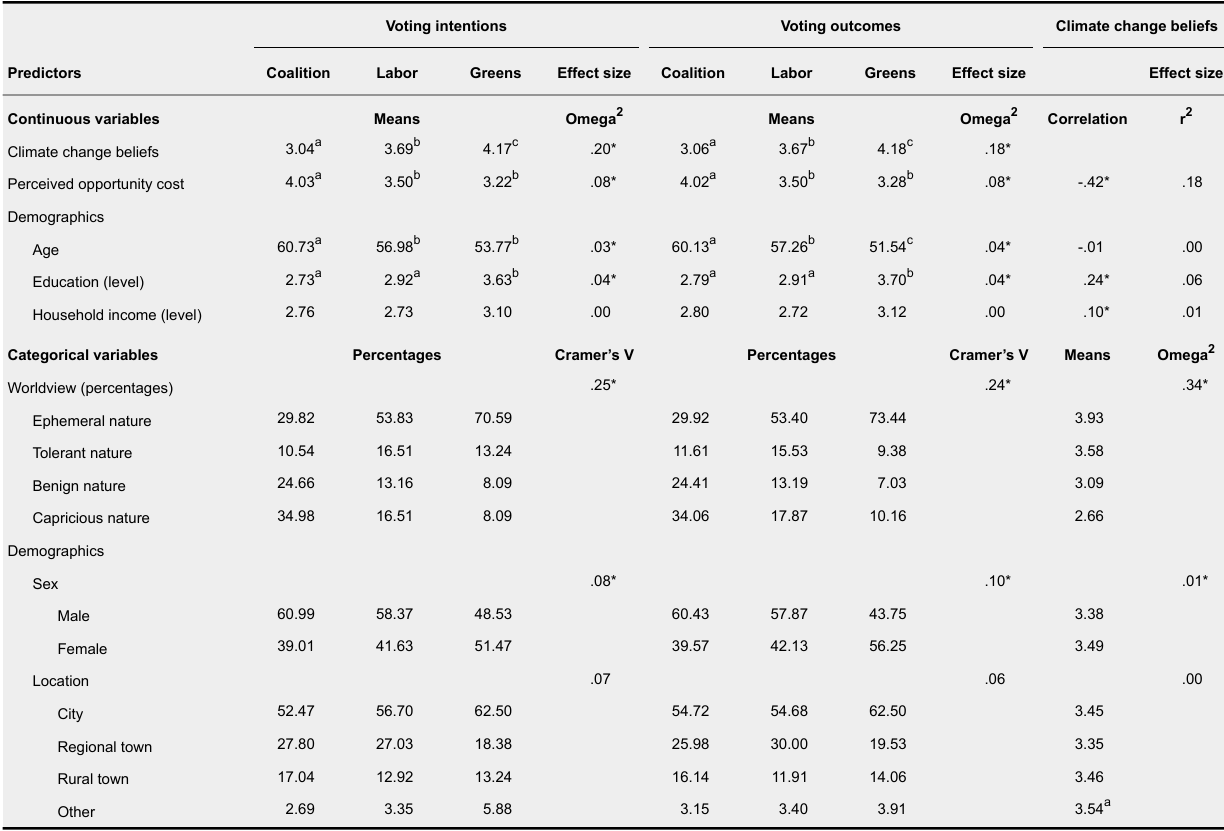
Voting Intentions, Voting Outcomes and Climate Change Beliefs: Bivariate Relationships With Worldview, Perceived Opportunity Cost, and Demographic Characteristics of Voters